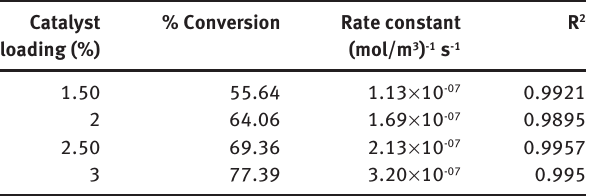
Table 3 Kinetic analysis for the effect of catalyst loading.